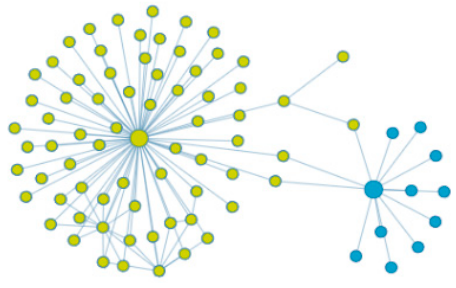
Figure 1. Illustration of structural holes.